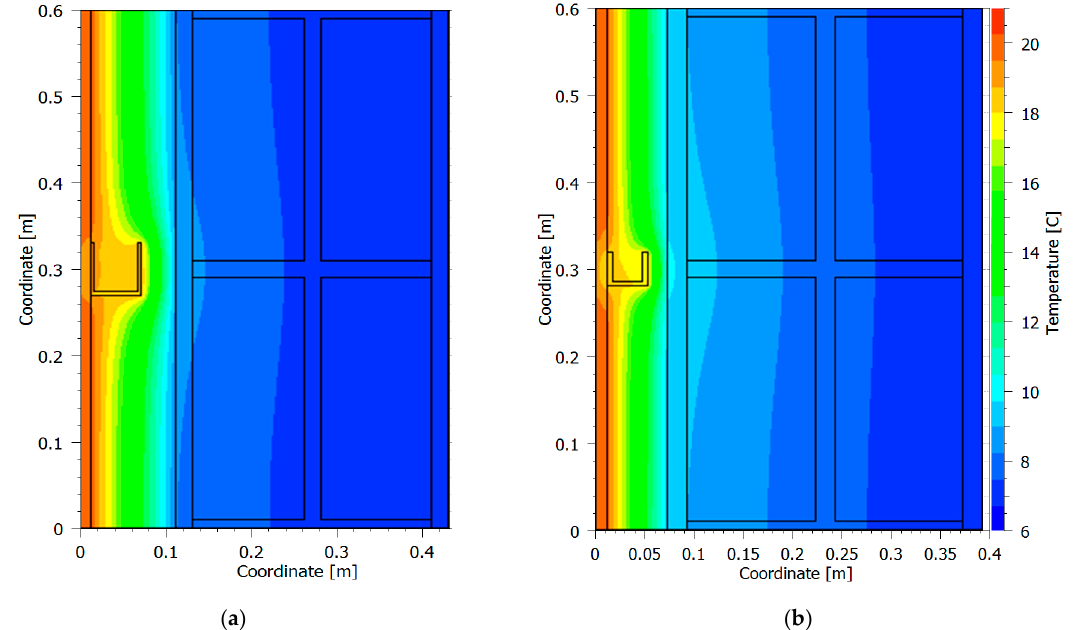
Figure 16. Temperature profile of the simulated wall during the coldest hour for 10 cm and 6 cm insulation scenarios. insulation